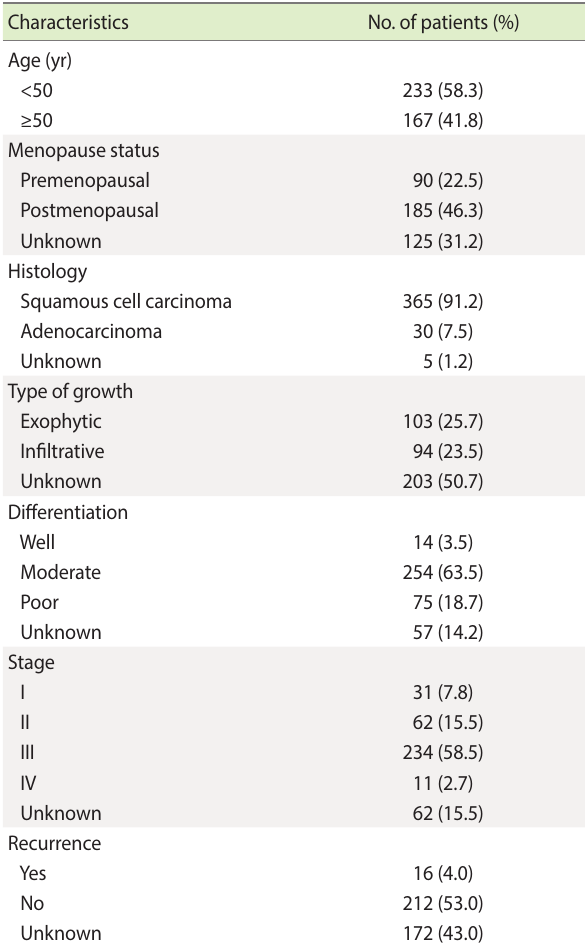
Table 2. Clinical and clinicopathological details of the cervical can- cer